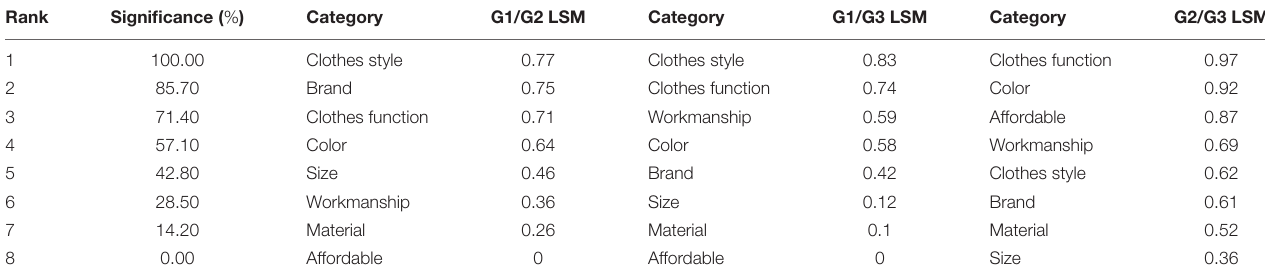
TABLE 4 | Product-centered language style (PCLS) priority rankings between